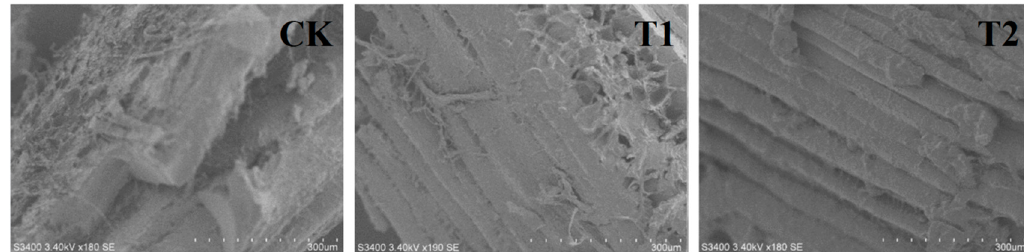
Figure 2. Changes in the microstructure of salmon treated with bacteriocin EFL4 during storage at 4 °C (CK: control; T1: salmon treated with 1MIC bacteriocin EFL4; T2: salmon treated with 2MIC bacteriocin